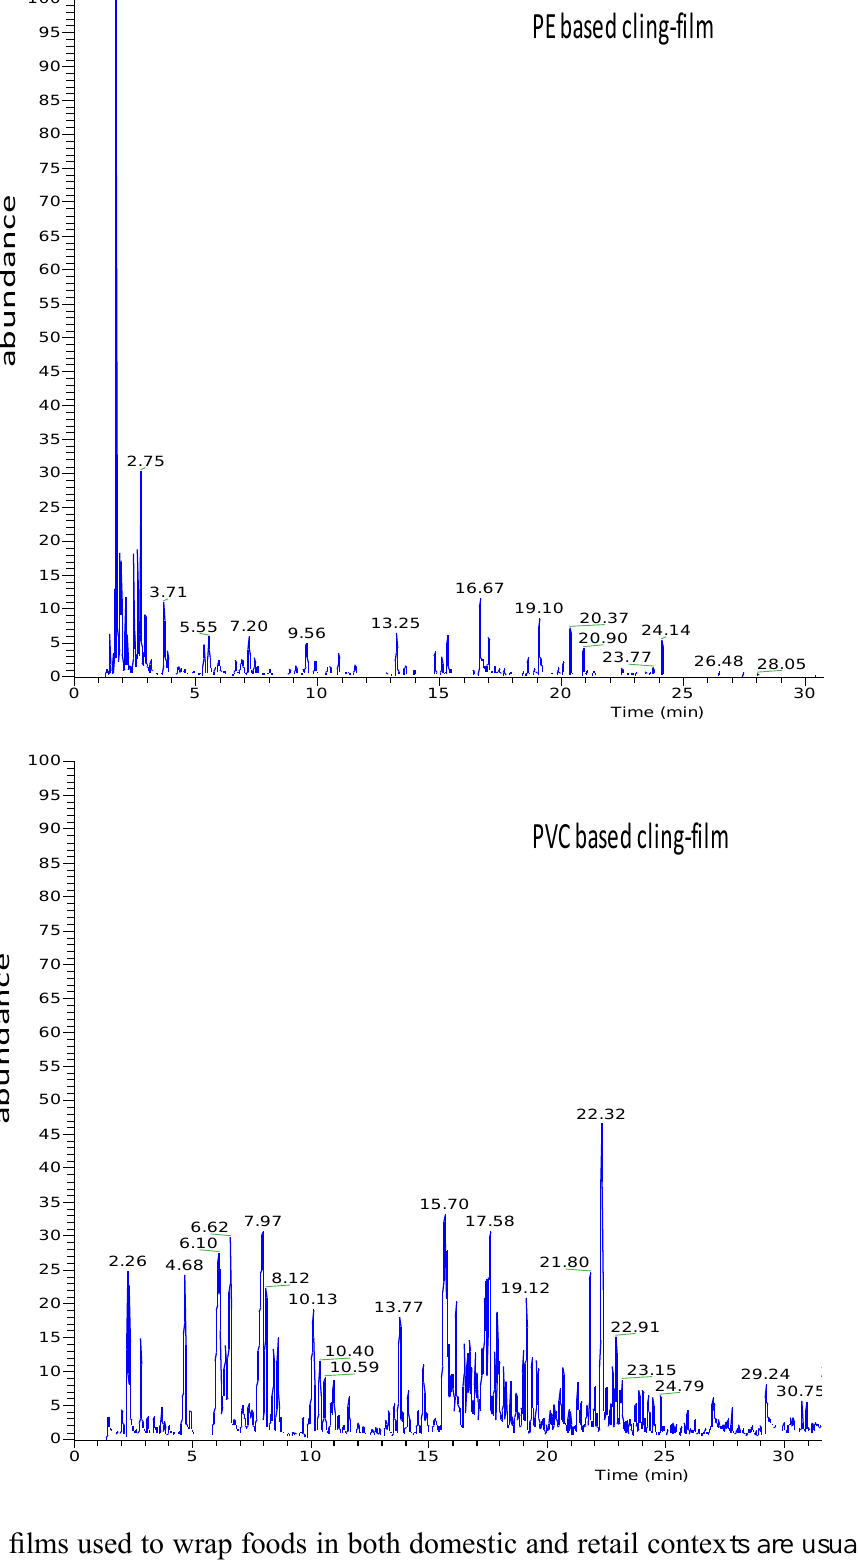
Figure 2. Chromatograms (total ion current-TIC) of PE based and PVC based